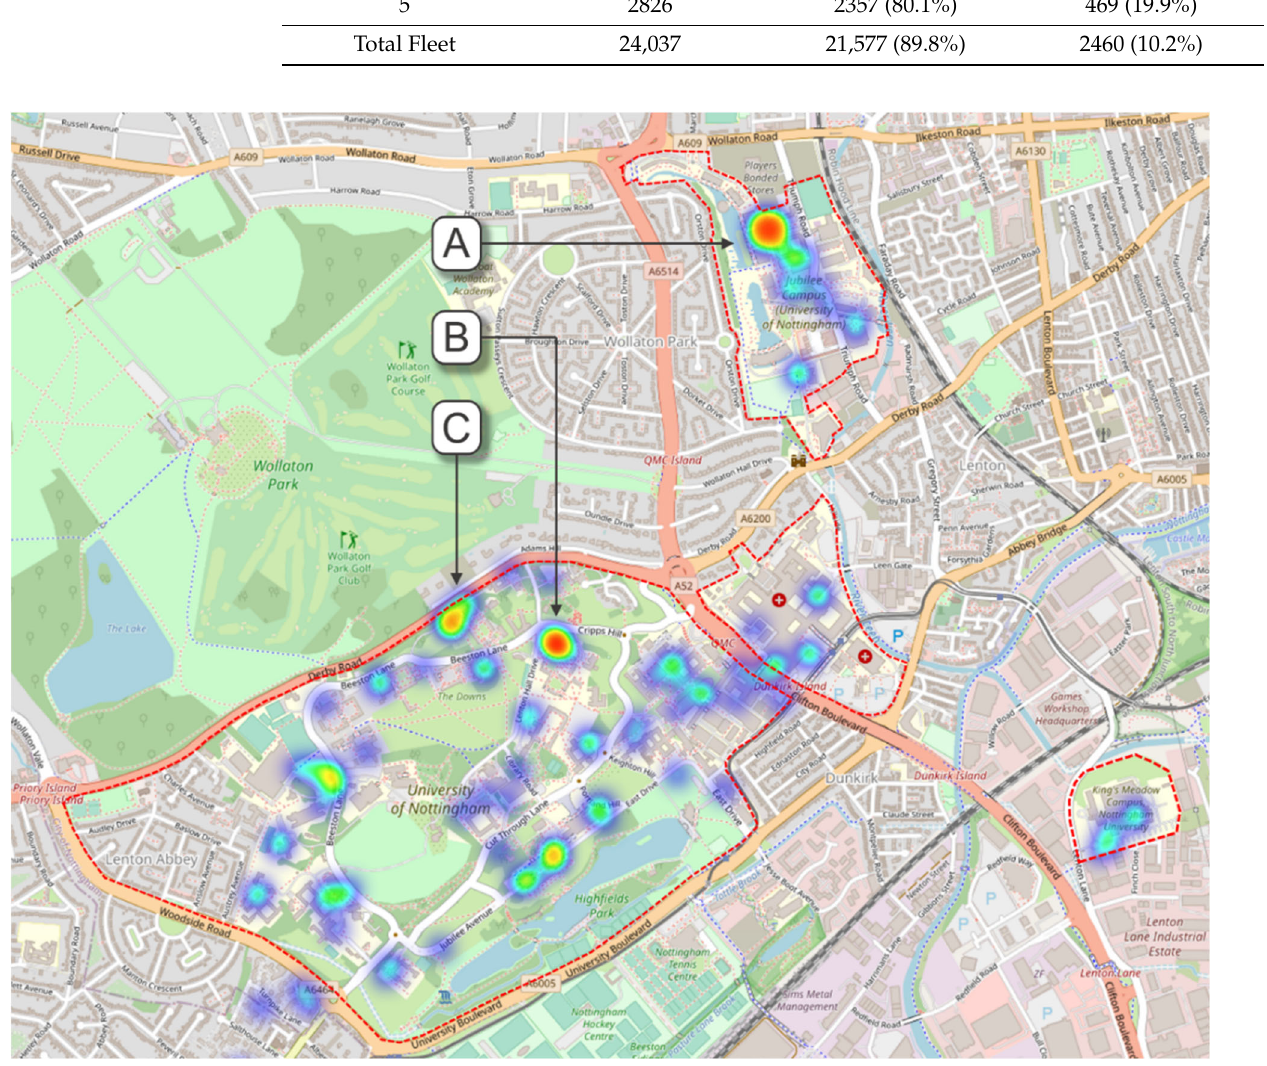
Figure 5. Geospatial analysis of long (> 60 min) dwell events at the University of Nottingham campuses in Nottingham, UK. The most frequent locations for long stops were identified as A, B, and C.